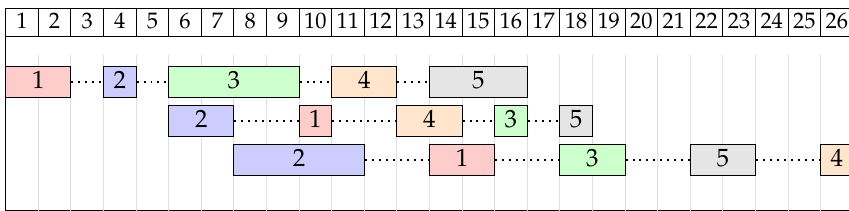
Figure 4. The left-shifted schedule for the instance from Example 2 and π = (( 1,2,3,4,5 ) , ( 2,1,4,3,5 ) , ( 2,1,3,5,4 ))